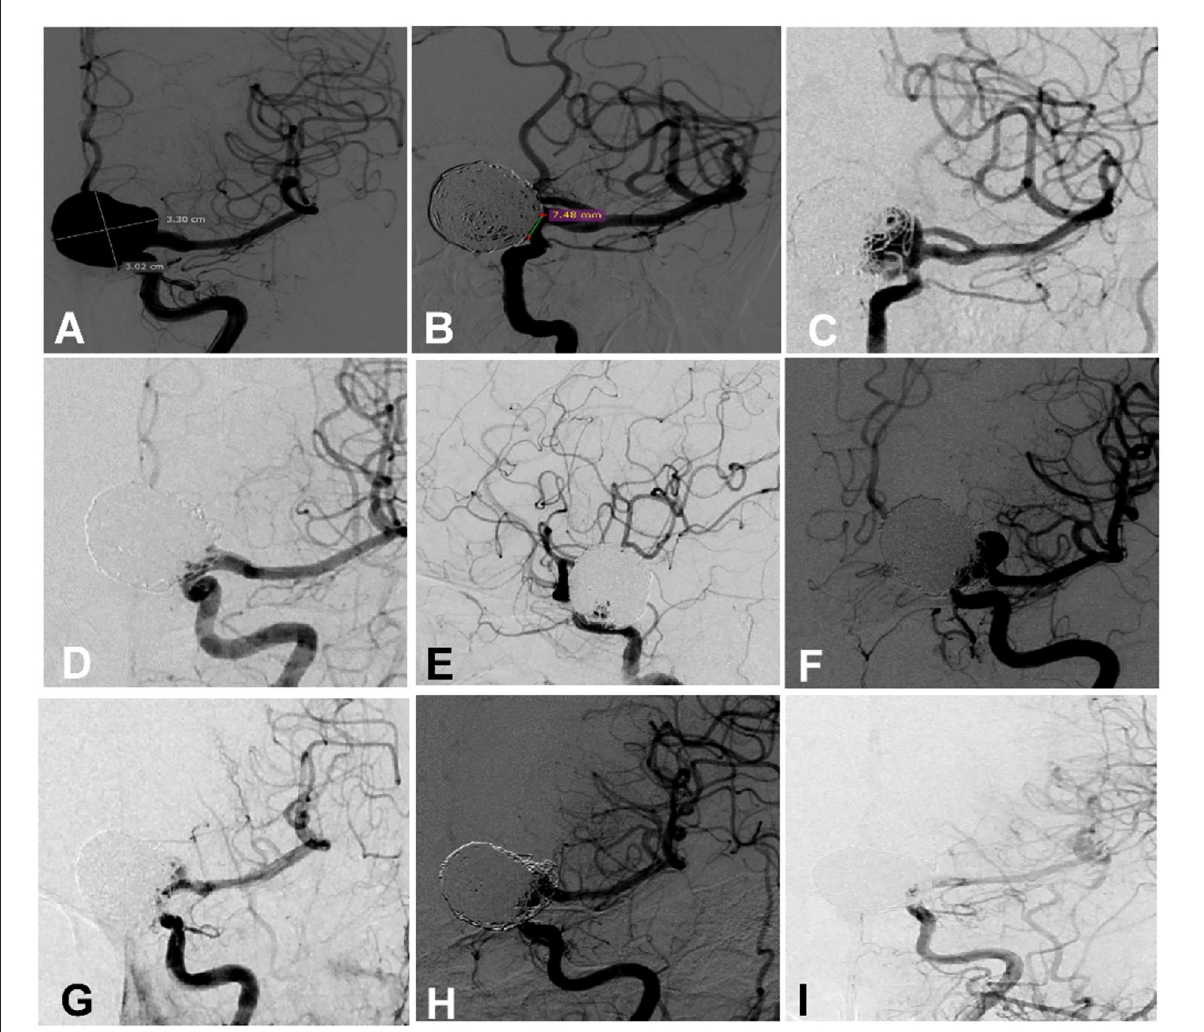
FIGURE1 A woman in her 50s had a giant aneurysm on the left ophthalmic artery segment which was treated multiple times. (A) Cerebral angiography revealed a giant aneurysm measuring 33.0 × 30.2mm with a 7.48mm neck. (B) The aneurysm was embolized with an Enterprise stent to assist coiling, resulting in near complete occlusion at the end of embolization. (C) Follow-up angiography 9 months later revealed recurrence of the aneurysm. (D,E) The recurrent aneurysm was treated with the deployment of an Enterprise stent to assist coiling, and near complete occlusion was achieved at the end of embolization. (F) Eight months later, the aneurysm was recurrent again. (G) At the third embolization, an Enterprise stent was deployed to assist coiling, resulting in near complete occlusion. (H) Four-month angiographic follow-up revealed that the aneurysm occlusion was stable. (I) Follow-up 1 year later revealed that the aneurysm was completely